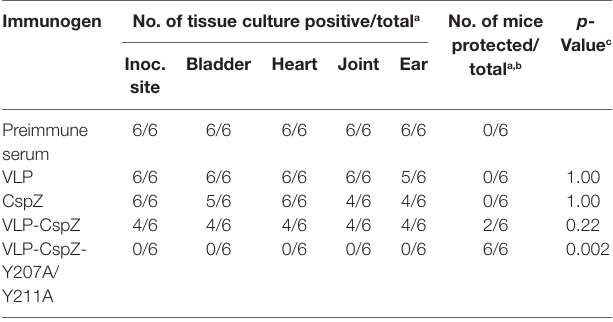
TaBle 1 | Protection against Borrelia burgdorferi in mice passively immunized with serum raised from CspZ- or virus-like particle (VLP)-immunized mice. immunogen